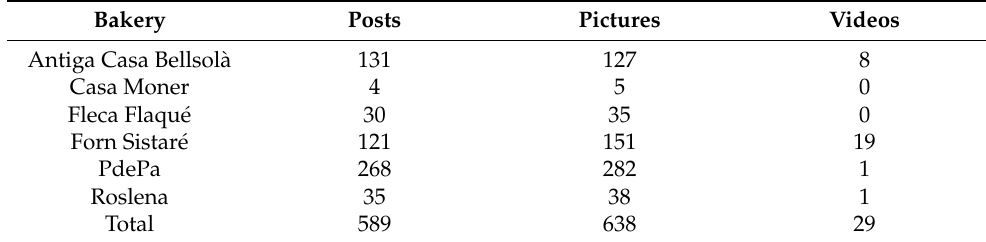
Table 2. Number of posts and images (and videos) of bakeries on Instagram.